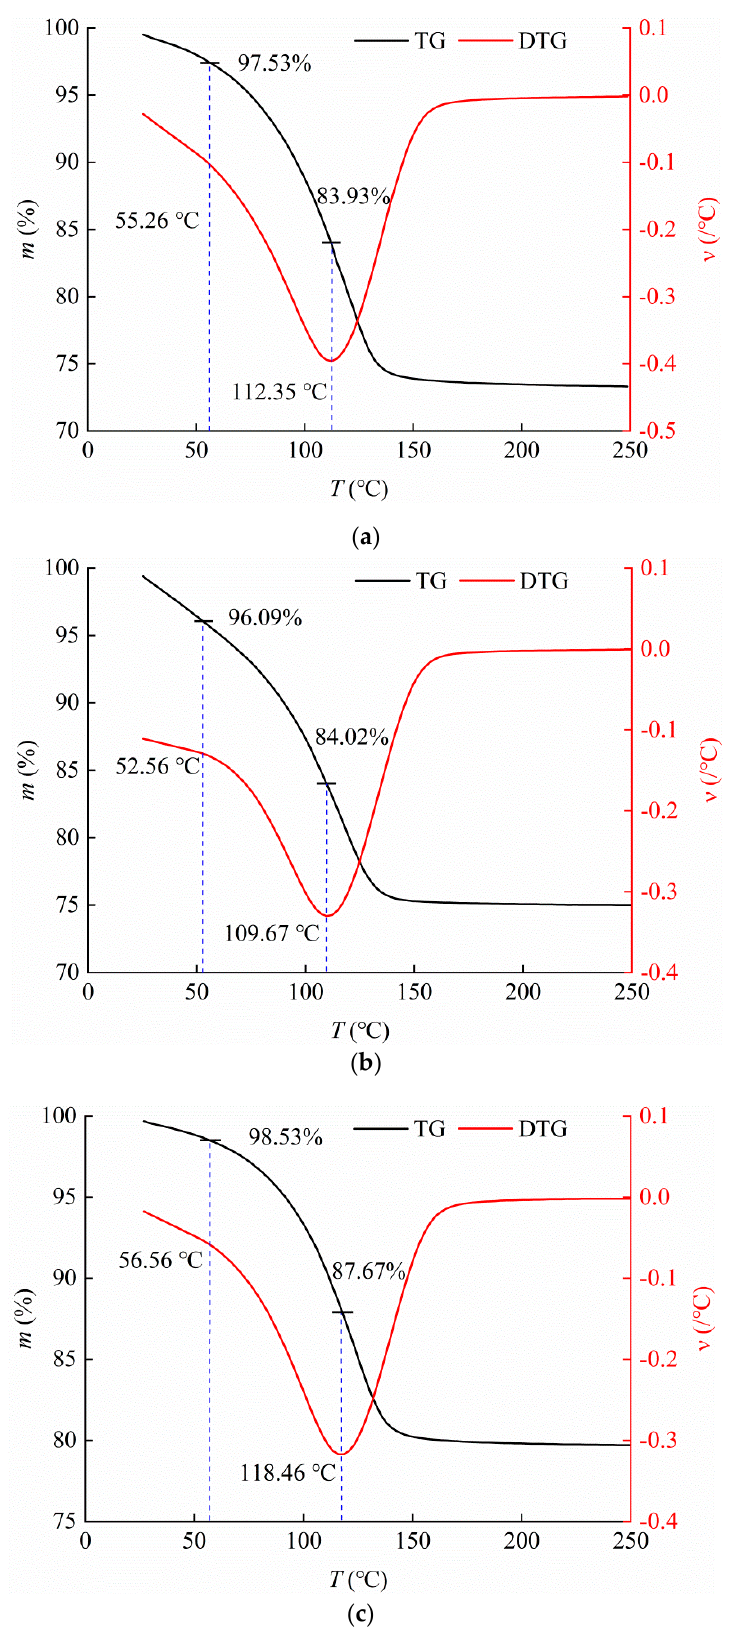
Figure 2. Thermogravimetric curves for ( a ) Tianjin clay, ( b ) Qingdao clay [34] and ( c ) Weihai clay. 3.2. Contents and Limits for Strongly Bound Water (SBW) and Weakly Bound Water (WBW)